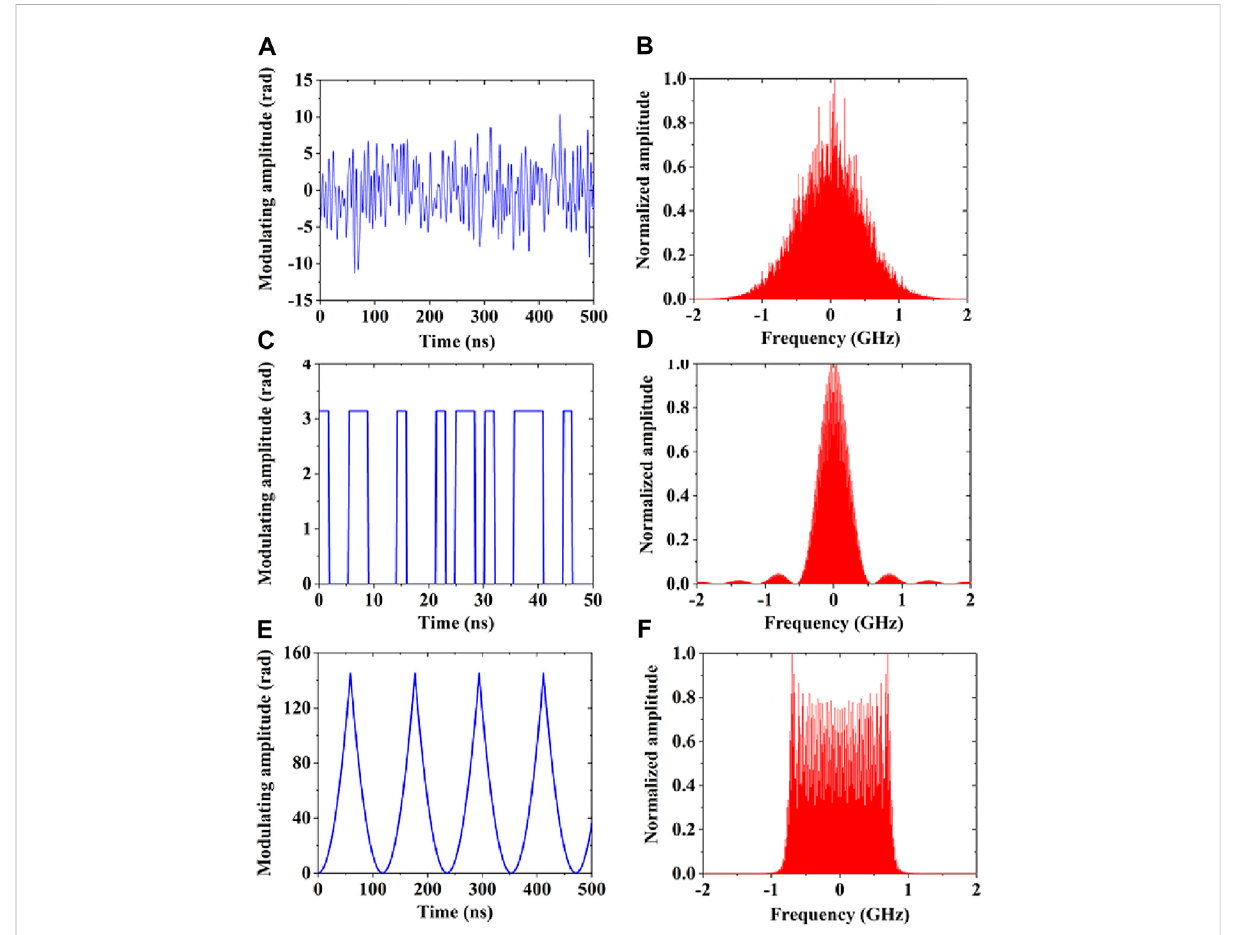
FIGURE 2 (A) WNS, (B) Gaussian spectrum modulated by WNS, (C) PRBS, (D) sinc 2 spectrum modulated by PRBS, (E) PPS, (F) rectangular spectrum modulated by